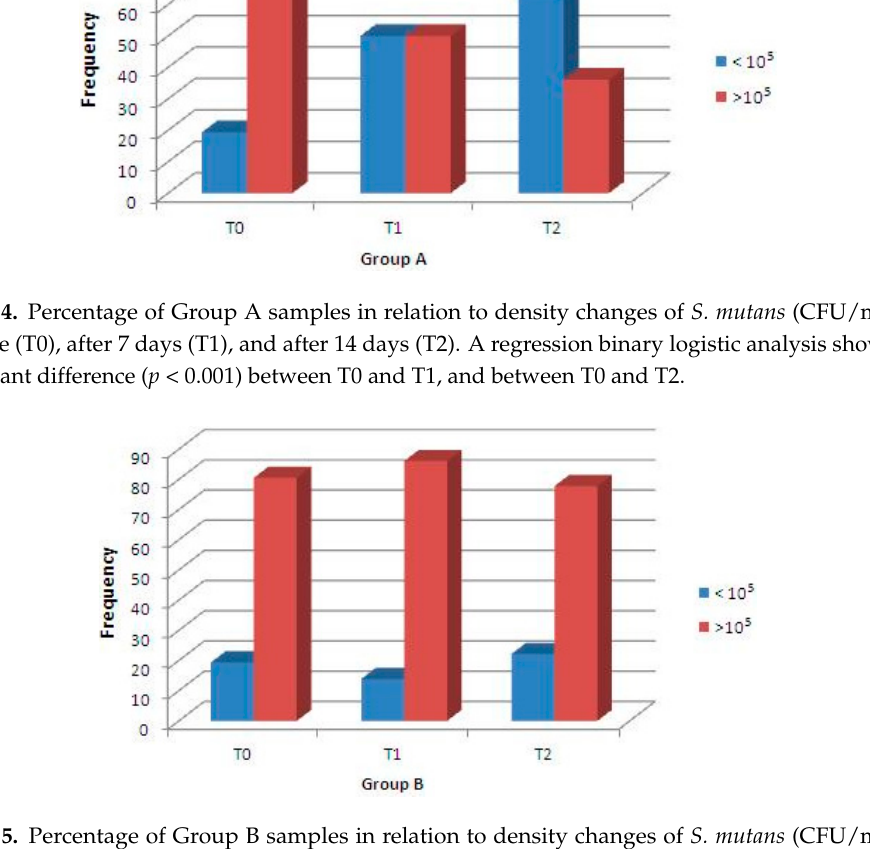
Figure 5. Percentage of Group B samples in relation to density changes of S. mutans (CFU/mL) at baseline (T0), after 7 days (T1), and after 14 days (T2). A regression binary logistic analysis did not show a significant difference between T0 and T1, and between T0 and T2.